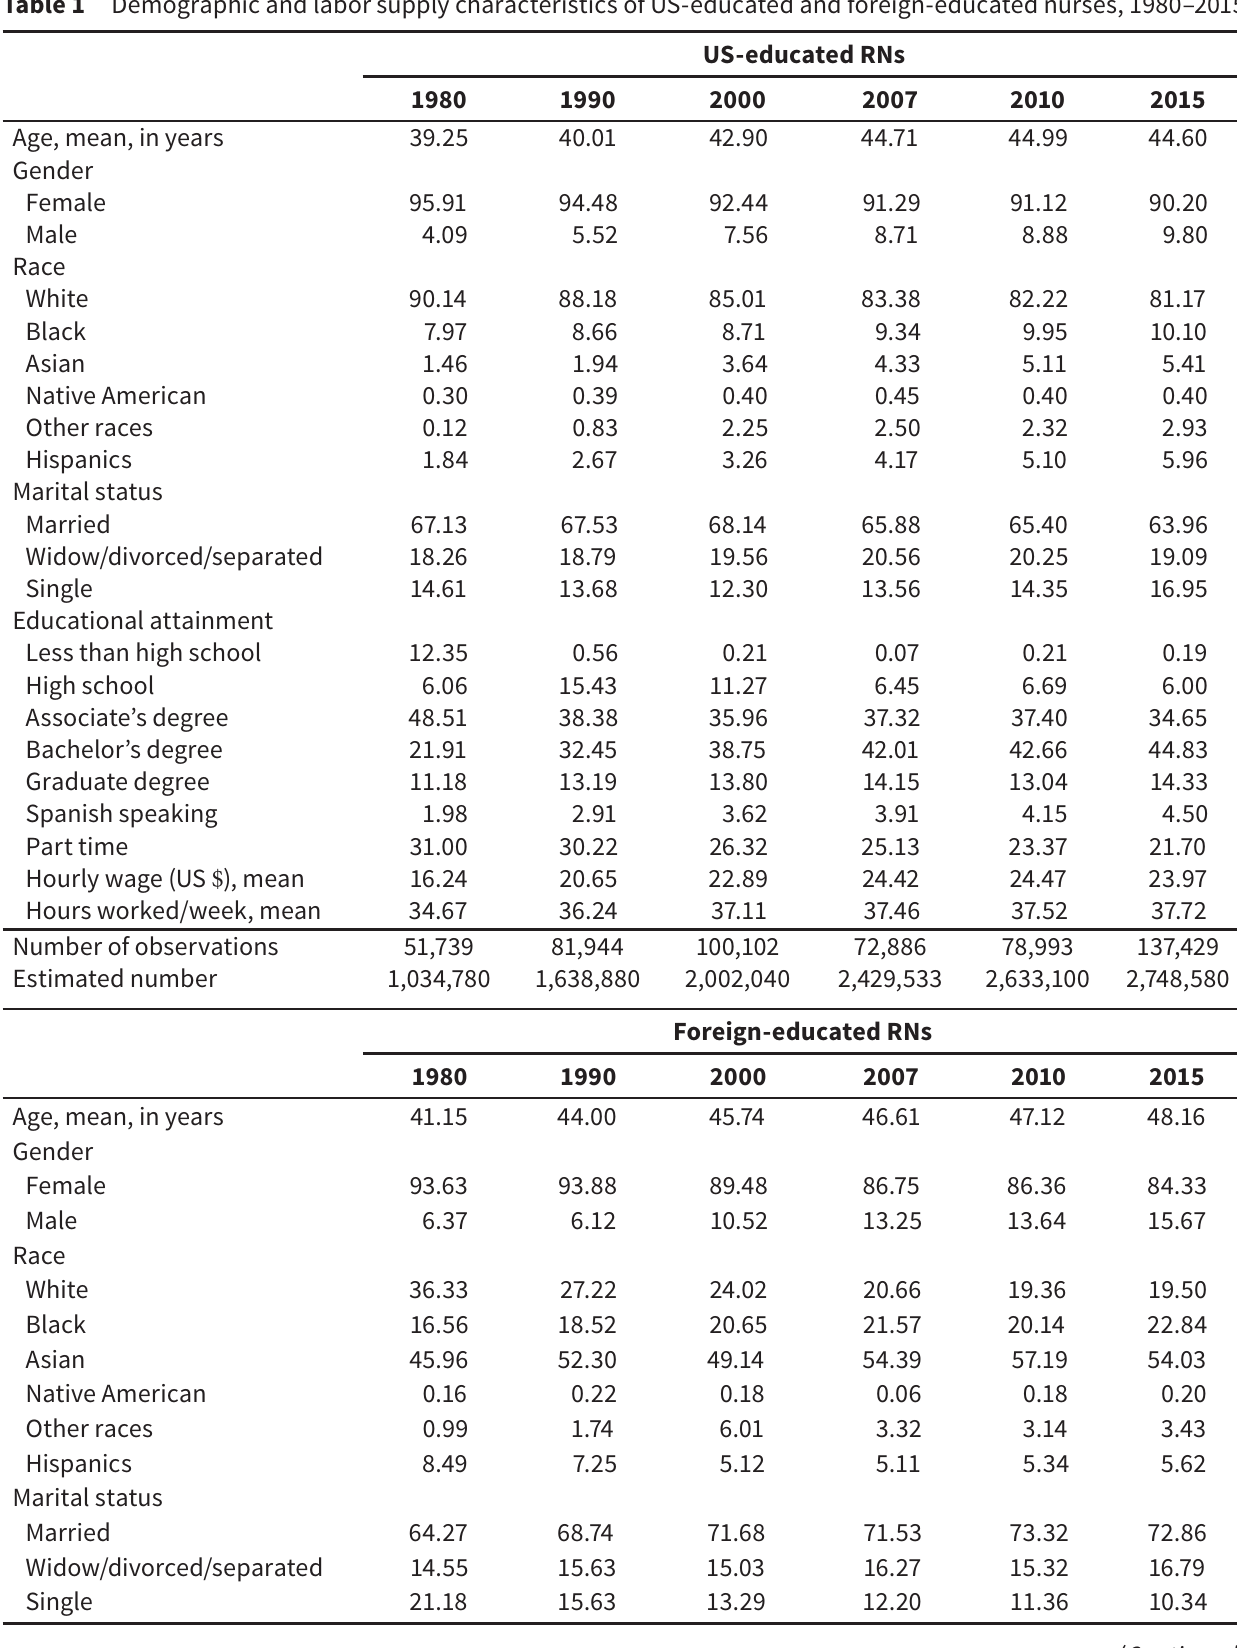
Demographic and labor supply characteristics of US-educated and foreign-educated nurses,